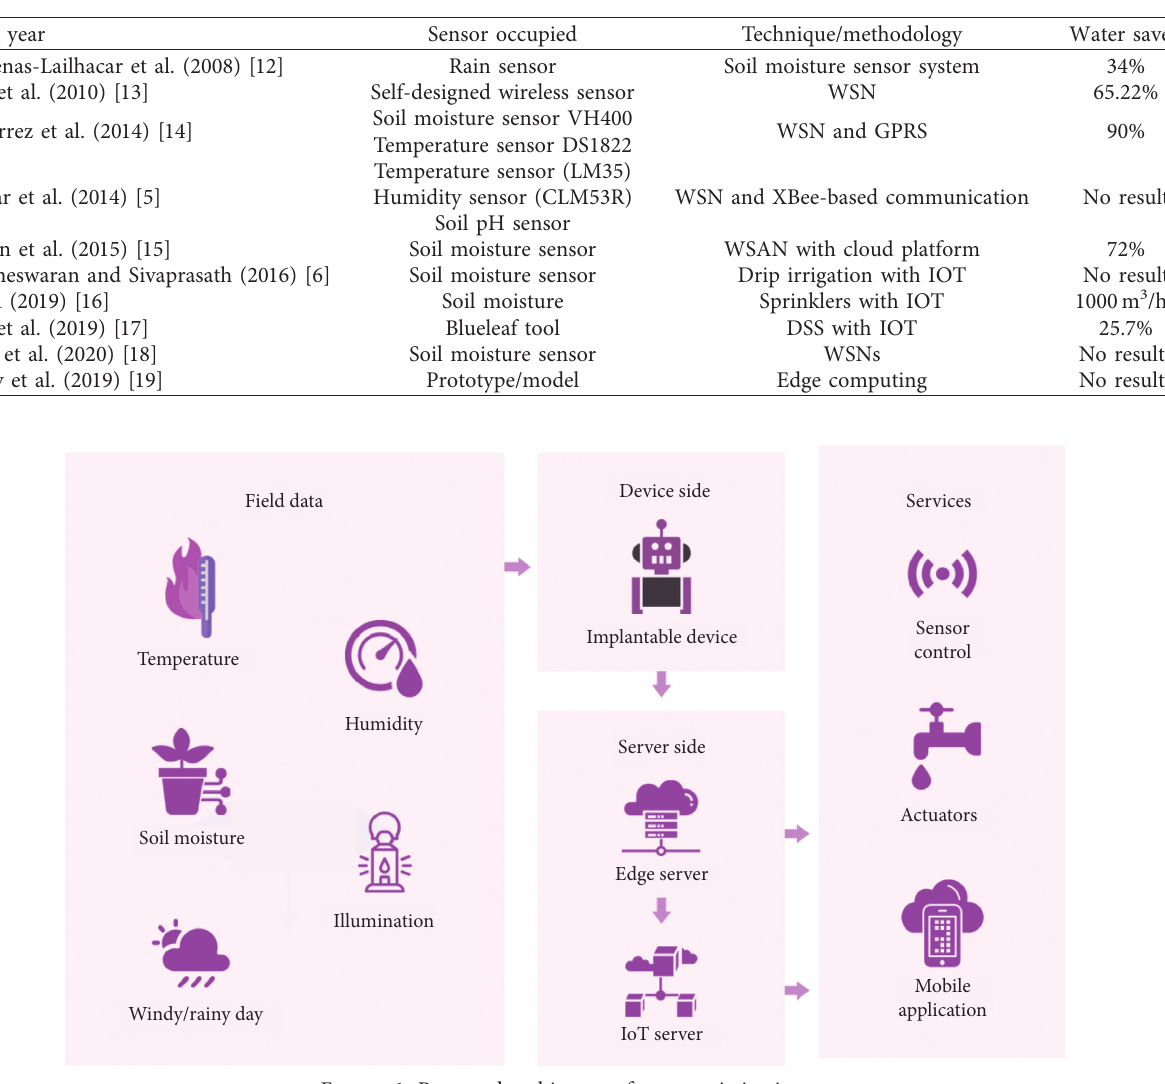
Figure 1: Proposed architecture for smart irrigation.